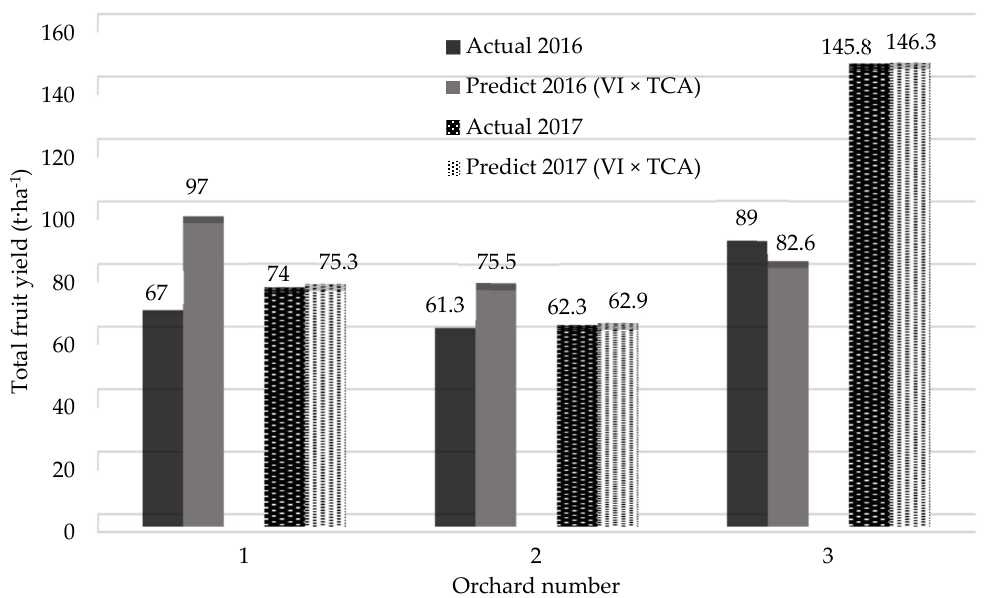
Figure 9. Comparison between the actual yield (t · ha − 1 ) to that predicted from WV3 imagery for 2016–2017 (showed as 2016 in legend) and 2017–2018 (showed as 2017 in legend) seasons for three mango orchards in Northern Territory.